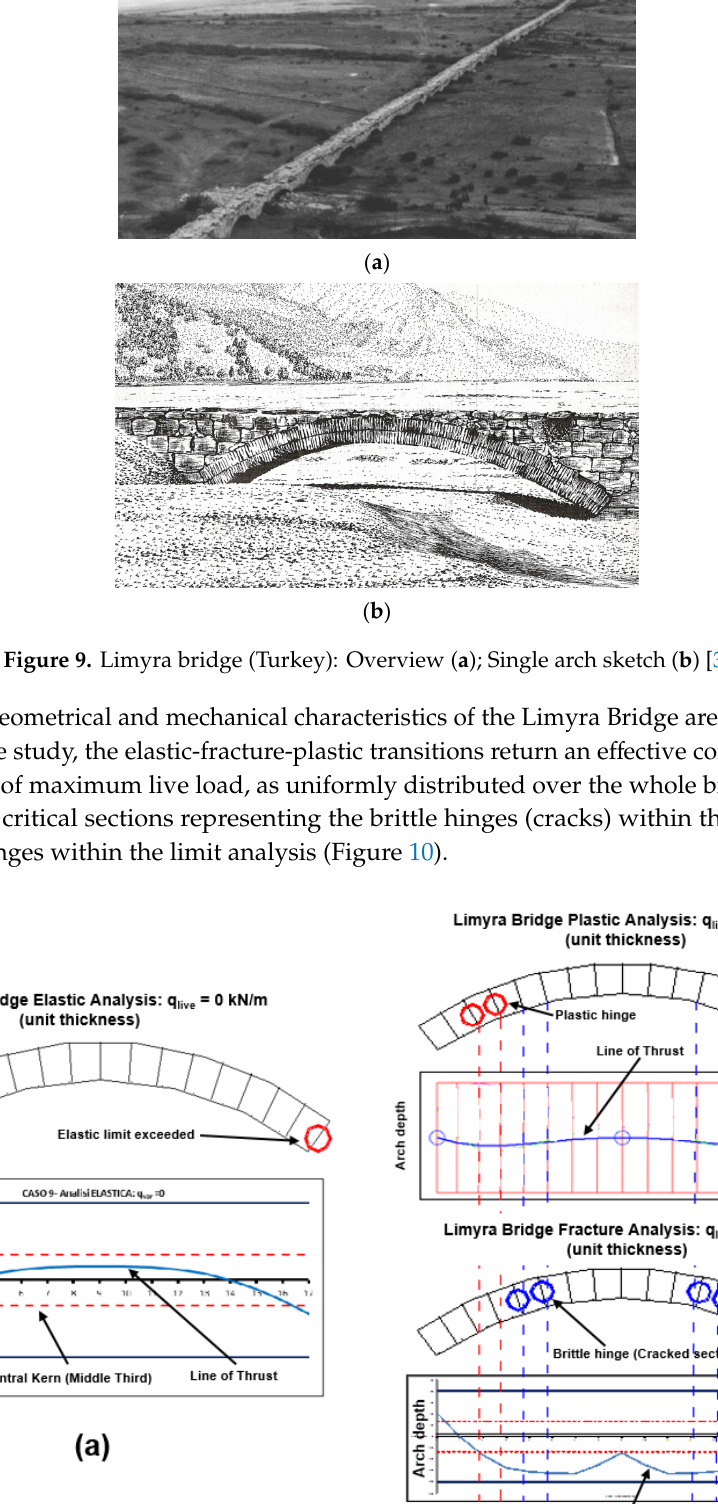
Figure 10. Limyra Bridge: ( a ) Elastic, ( b ) plastic, and ( c ) fracture analyses.